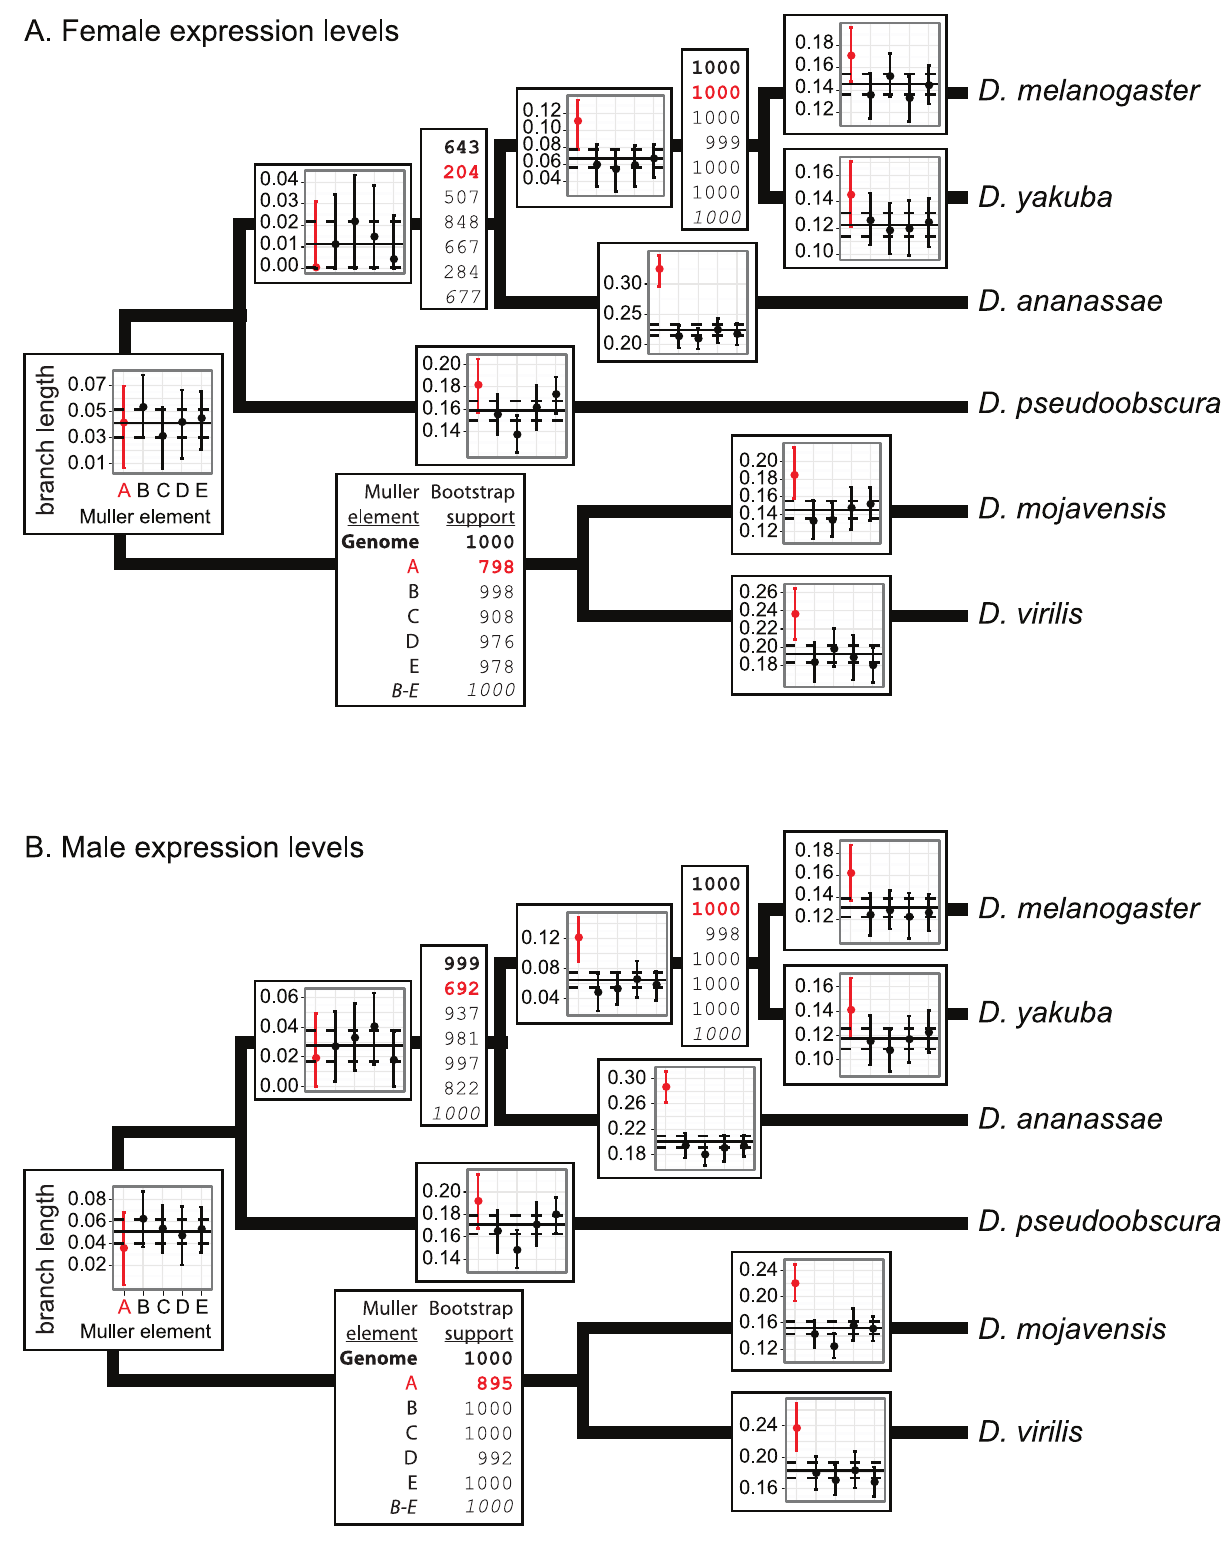
Figure 4. Branch length estimates and bootstrap support from expression level divergence. Overlaid on each branch of the phylogeny are the branch lengths estimated from the pairwise correlations in expression (measured in whole flies with microarrays) using the Fitch and Margoliash [115] method. In each graph, the solid horizontal line is the genome-wide branch length, and the dashed lines are the 95% CI. Each point represents the branch length estimate for a chromosome arm (X is in red), and the error bars are the 95% CI. Bootstrap supports for the nodes are listed in the boxes adjacent to the nodes. The first number, in bold, is the bootstrap support using all orthologs, and the subsequent five values are